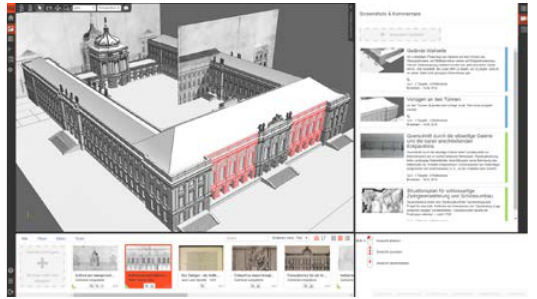
Figure 3. 4D browser